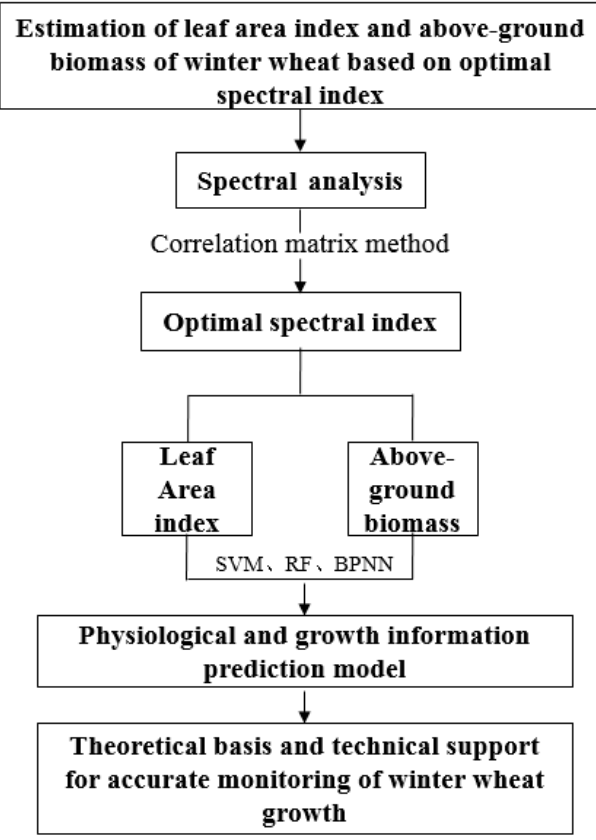
Figure 2. Diagrams of architectures used in the experiments.